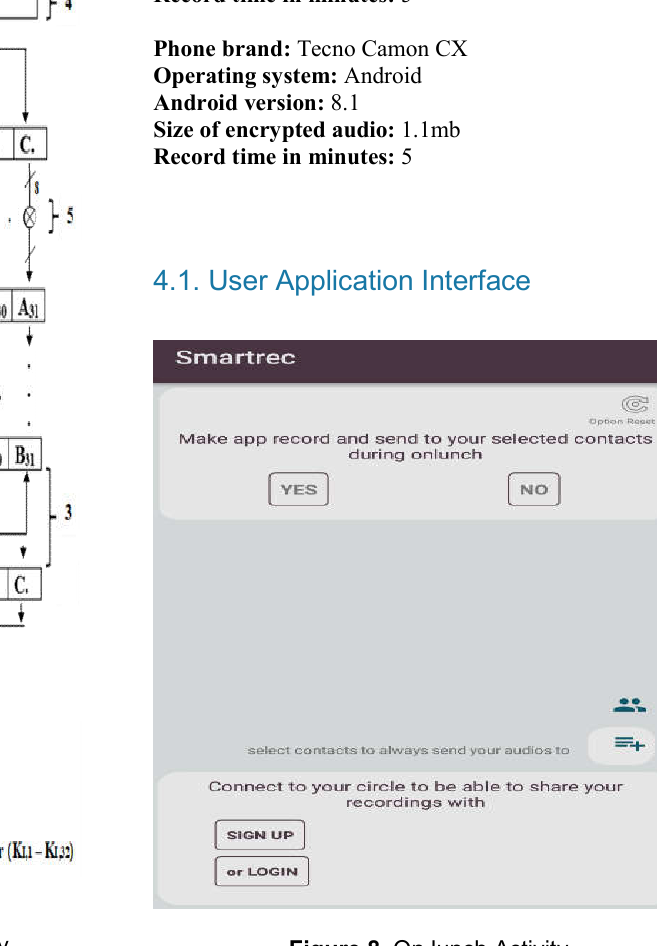
Figure 7 . Generation of AES Cypher Key Figure 8 . On lunch